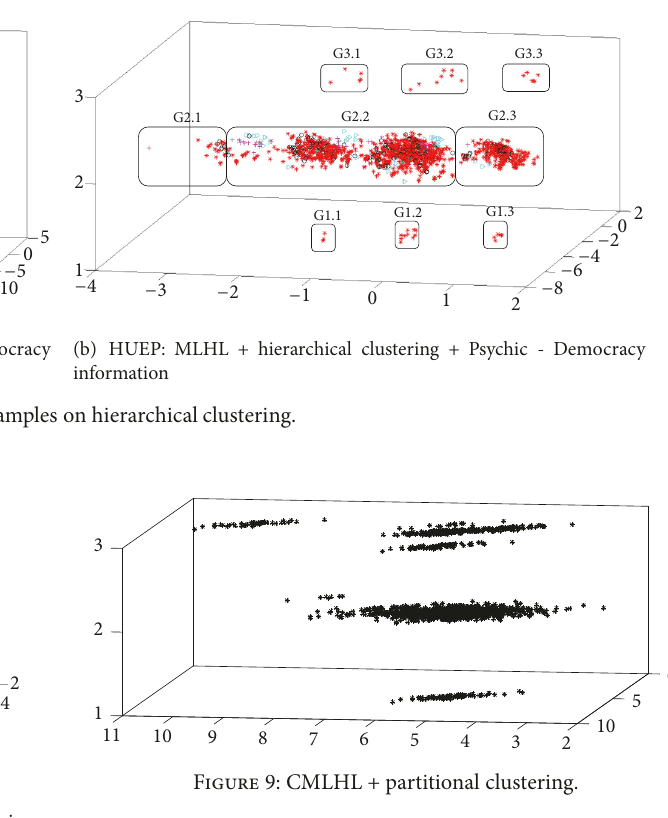
Figure 8: HUEP: CMLHL + hierarchical clustering + Psychic - Democracy information.